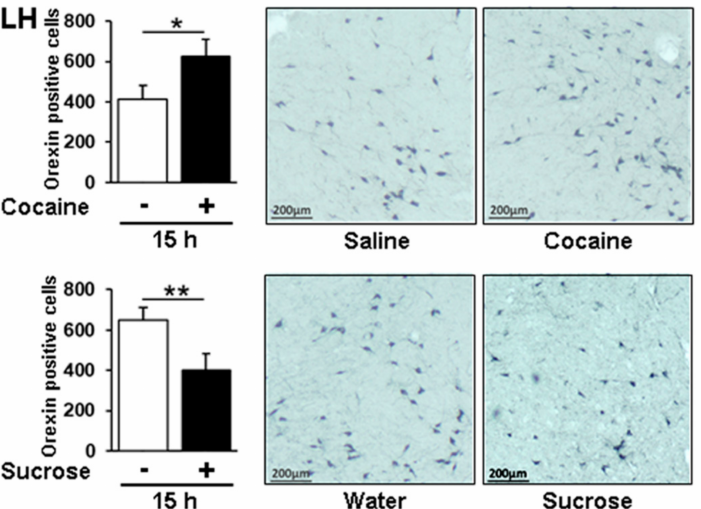
Figure 8. Effect of passive administration of cocaine or sucrose on orexin peptide in the lateral hypothalamus by IHC. Quantification and photomicrographs showing orexin immunoreactivity at ZT 16 in the LH of rats treated daily for 10 days with saline or 20 mg/kg cocaine (one i.p. injection per day) or with sucrose (10 days, one oral administration per day). Statistical analysis performed was one-way ANOVA followed by Newman-Keuls post hoc test. Significant differences are indicated